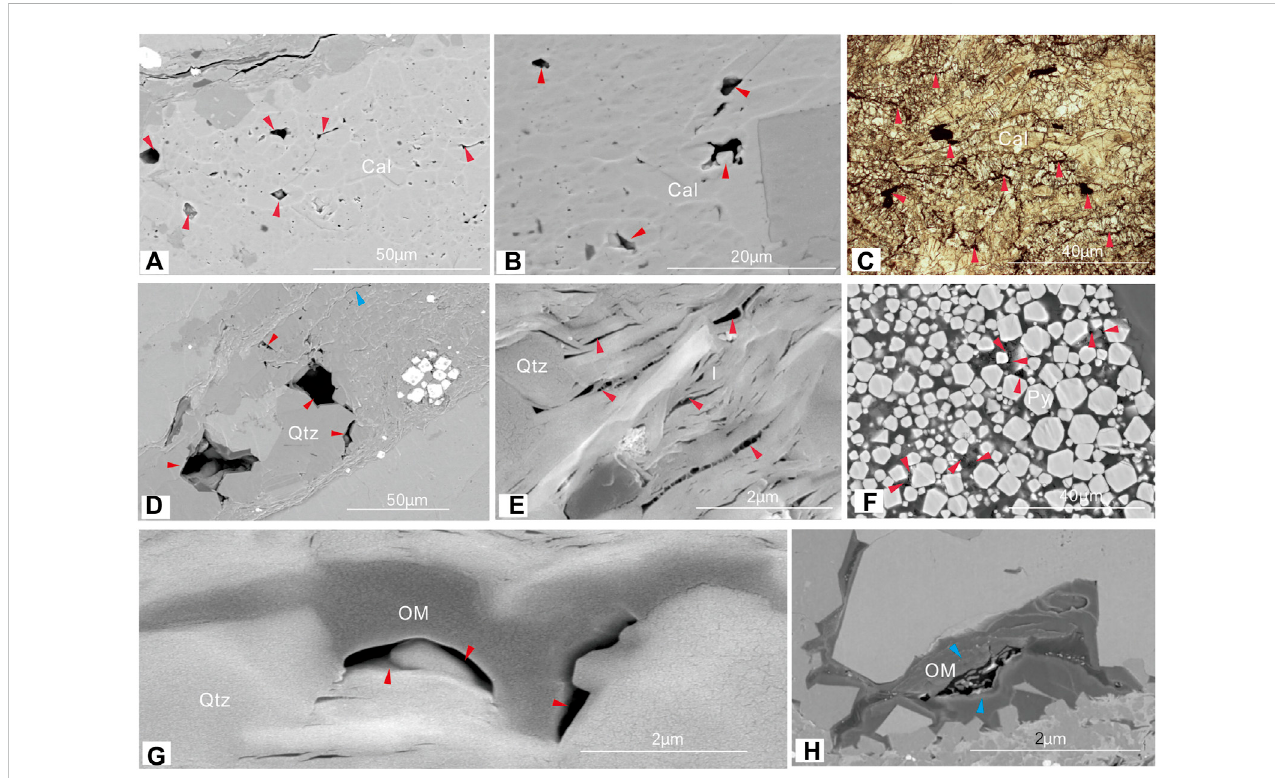
Photomicrographs of shale reservoirs in the Da ’ anzhai Member in Well RA1; (A) intergranular pores in shell calcite, 2,453.13 m; (B) intergranular dissolutionporesinshellcalcite,2,453.13 m; (C) authigeniccalciteintergranularpores(redarrow),2,449.94 m; (D) authigenicquartzintercrystallineporesand